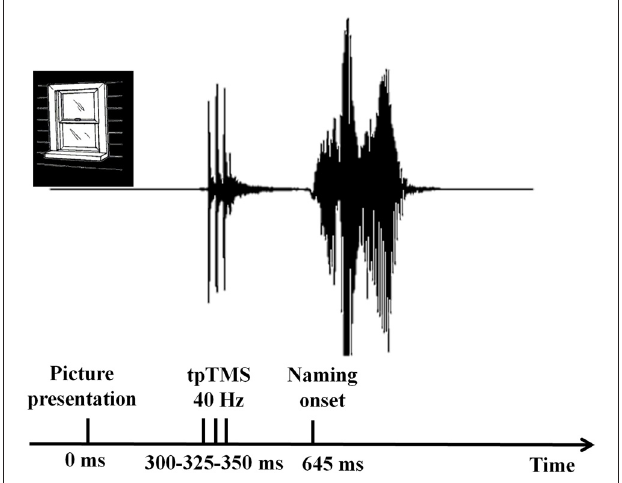
FIGURE 3 | Verbal response time analyses. The latency of the verbal responses was measured using the speech wave envelopes with digital audio editing software cooledit v2.1. Naming onset was defined as the first detectable amplitude in the speech wave